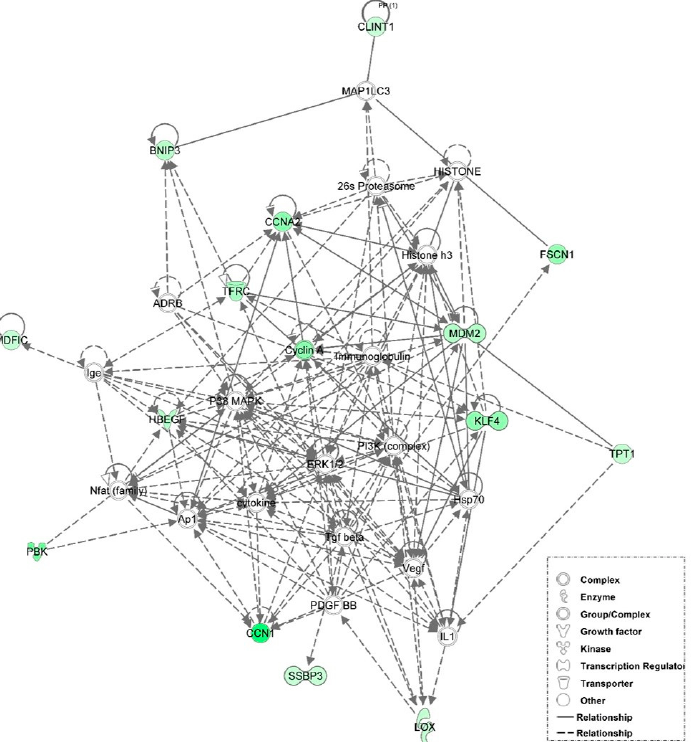
Figure 6. Network mapping of miR-145 target genes. MiR-145 expression in the adipose tissue increased from E18 to D3. MiR-145 target genes found to be downregulated during this period include those associated with cellular development, cellular growth and proliferation and cellular movement. Green molecules were significantly ( p < 0.05) downregulated from E18 to D3. Solid lines indicate a direct interaction and dashed lines indicate an indirect interaction.